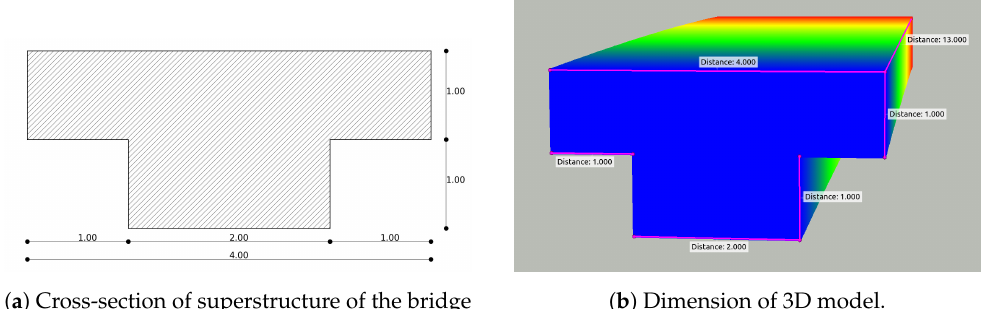
Figure 7. Comparison of the dimension of the 3D reconstructed point cloud ( b ) and the designed dimension from the plan ( a ); the depth of the point cloud is described with blue-red color-scale from 0 to 13